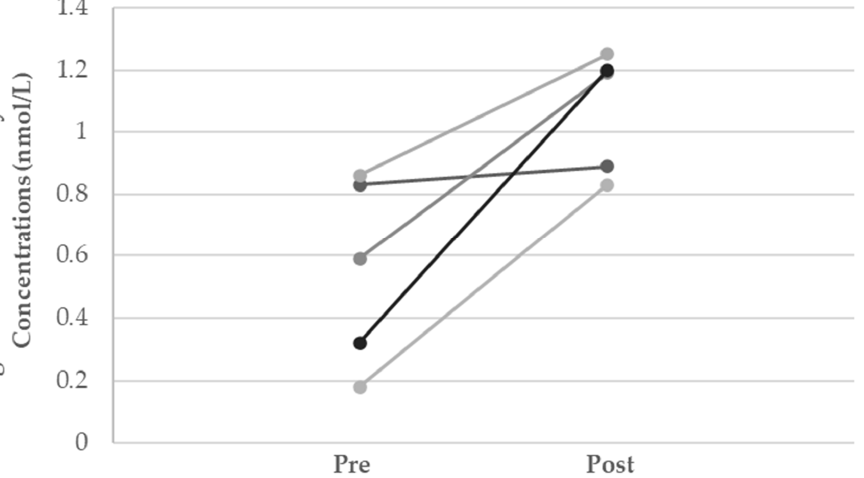
Figure A4. Plot showing changes in salivary cortisol concentrations pre- and post-participation in beaver dam breaking for all participants.